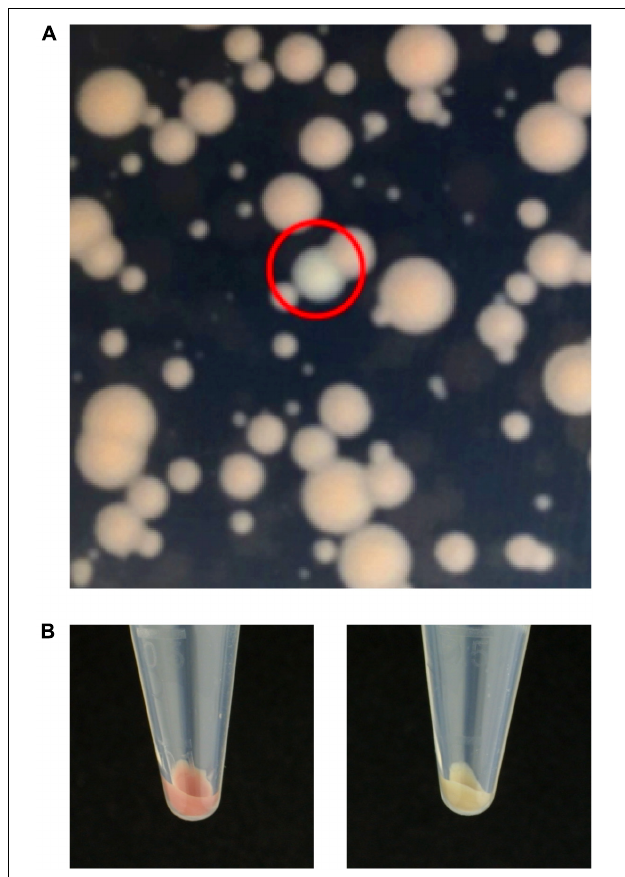
FIGURE 2 | Genetic screen for genes involved in S. oneidensis colony color. A mini-ISY100 insertion library was generated and plated on LB/Kan to screen for mutants that had lost the red-brown coloration. (A) Close-up of kanamycin resistant S. oneidensis colonies obtained after conjugation with MFD pir /pISY100mini. Heterogeneity in colony size might be due to fitness differences caused by transposon insertions. Alternatively, small colonies might reflect late (post-plating) transposition events. A mutant with pale colony color is circled in red. (B) Pellets obtained after centrifuging 2.8 ml LB liquid cultures (30 ◦ C, overnight) showing the difference in color between the wild-type S. oneidensis (left) and a pale mutant (right).